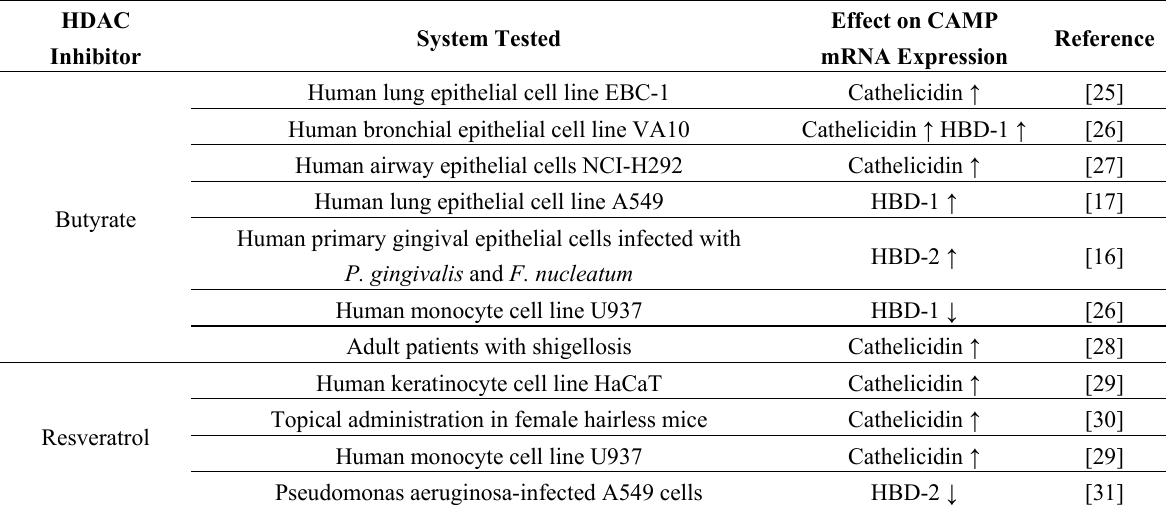
Table 1. HDACi that have been evaluated for the capacity to induce CAMPs in vitro and in vivo